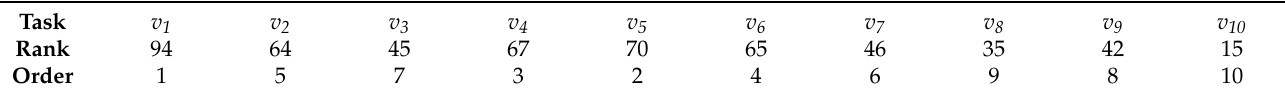
Table 1. Task scheduling priority sample